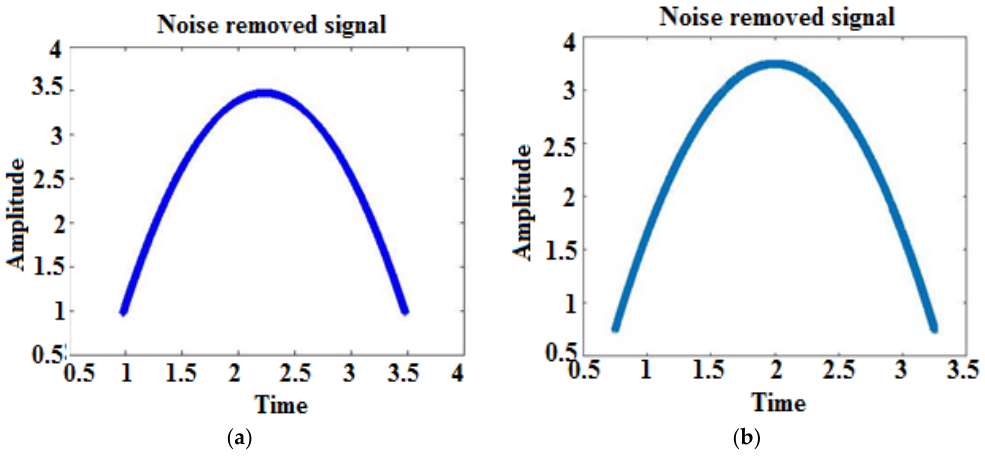
Figure 7. Noise removed signal. ( a ) Proposed method; ( b ) Existing method (FsLMS).